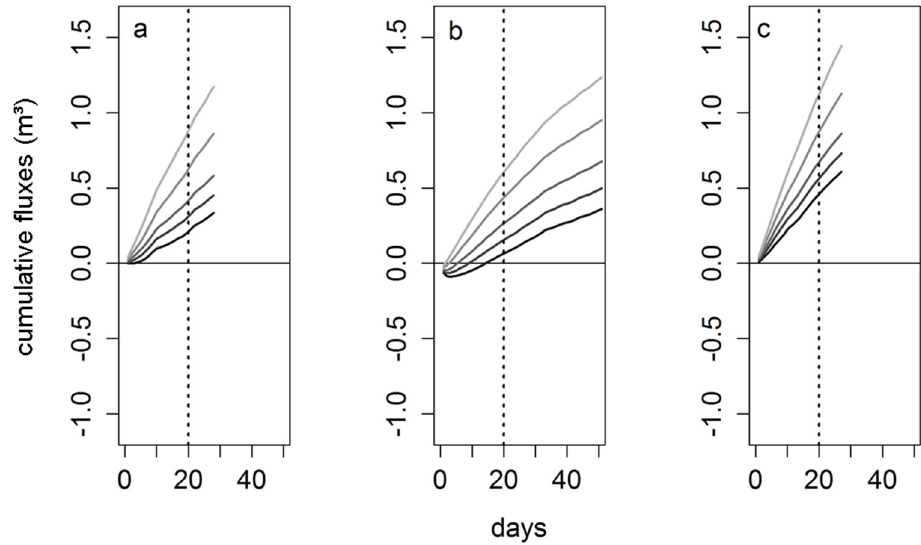
Figure 6. Evolution of groundwater levels for the model domain based on the scenario 50 cm water level in the ditches for the period of 26 April–22 May 2012 (lateral boundaries: right stream and left Ditch 2 at P5-2). The lines correspond to 0, 5, 10, 15, and 20 days of simulation time (from black to light gray). The ditches and stream are given as dashed lines.